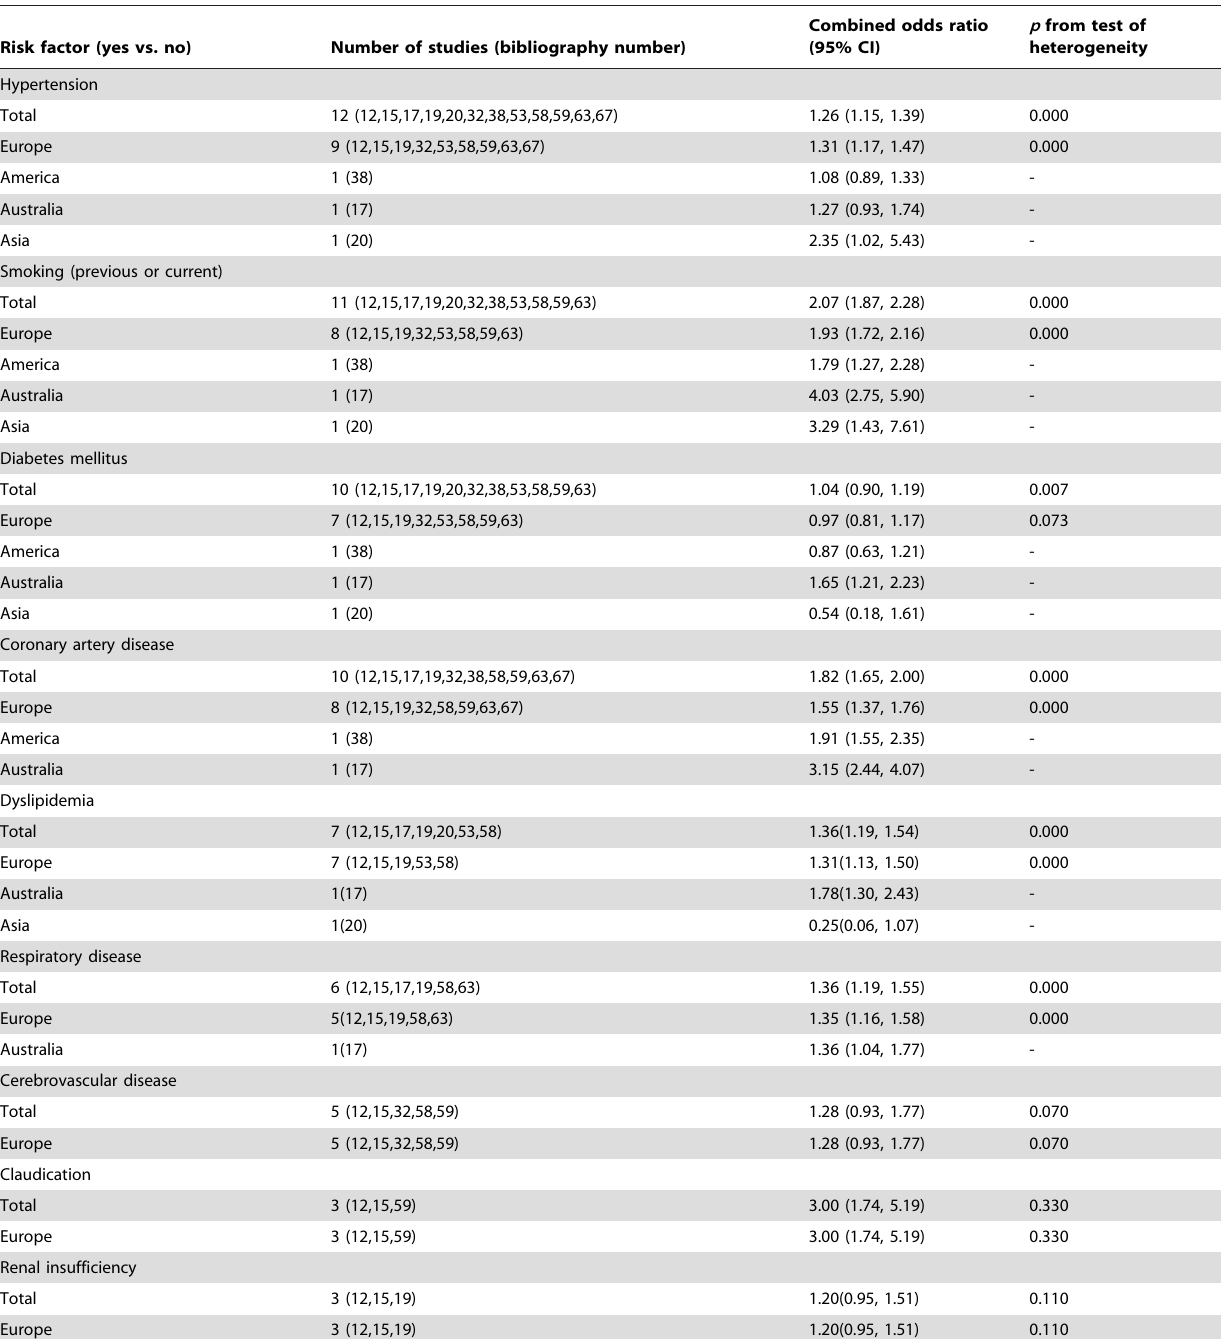
Table 3. Combined odds ratios for the presence of abdominal aortic aneurysm from meta-analysis.